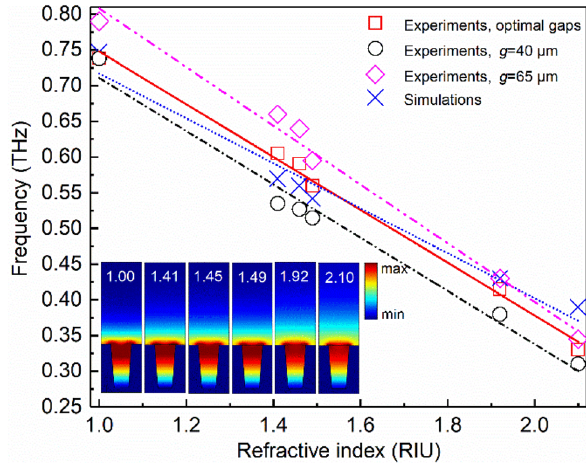
Figure 9: The variation of resonance frequency versus refractive index of liquid for experiments and simulations and their correspondinglinearfittingcurves.Theinsetsshowtheelectricfield distributions for the unit cell of the grooves filled with various refractive